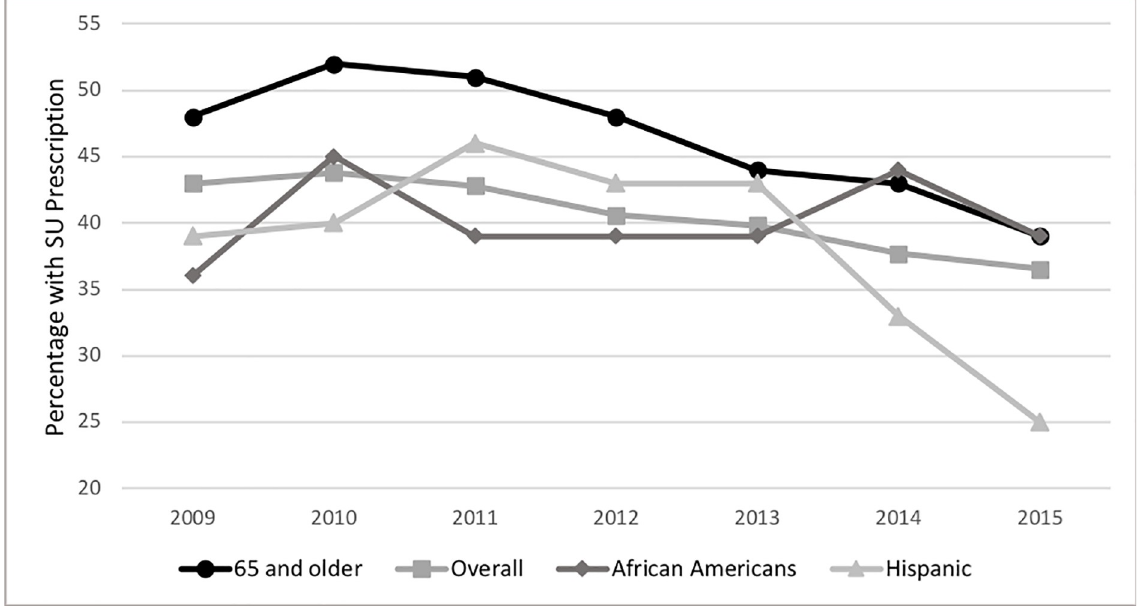
Fig 2. Sulfonylurea prescriptions overall and in subjects 65 or older. SU: sulfonylurea.